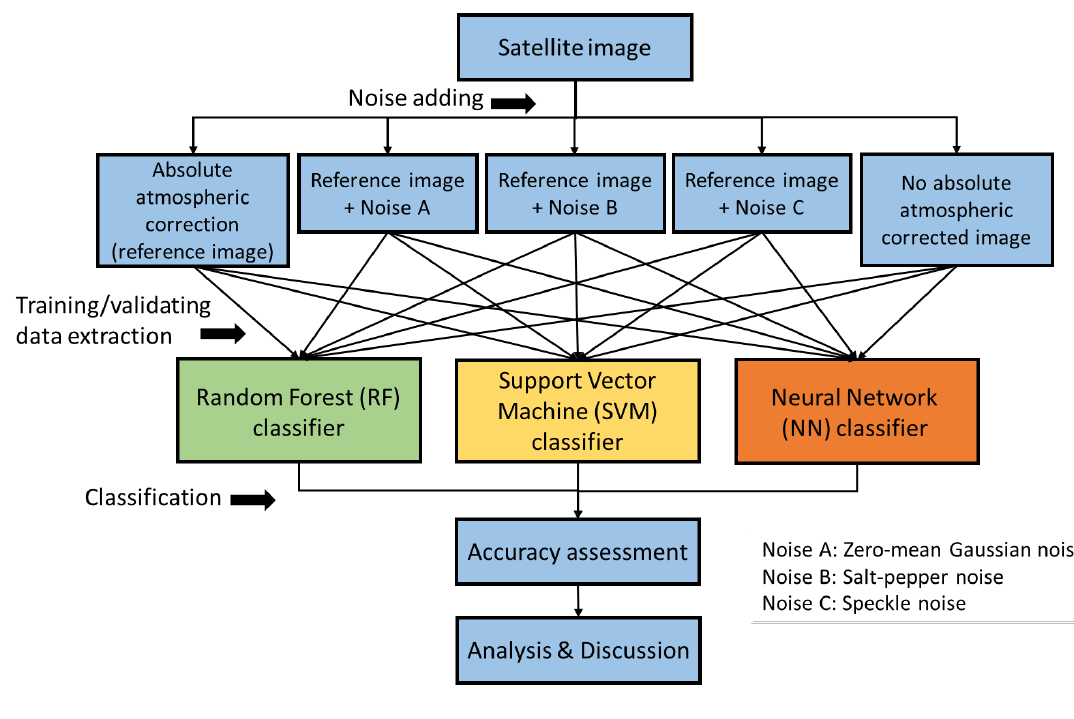
Figure 1. Experimental flow.